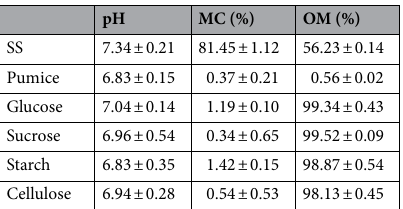
Table 1. The characteristics of the raw materials. The results are the mean ± standard deviation (n = 3). MC moisture content, OM organic